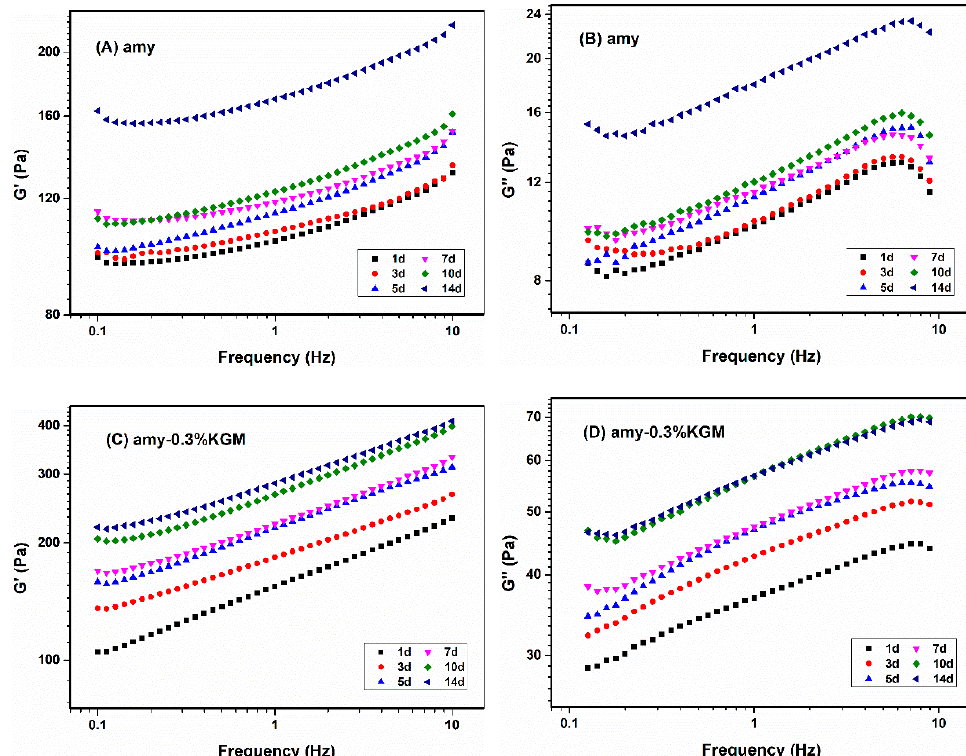
Figure 3. Frequency sweeping curves of amylose and amy-0.3%KGM at different storage times. ( A ) storage modulus of amylose; ( B ) loss modulus of amylose; ( C ) storage modulus of amylose mixed with 0.3% KGM; ( D ) loss modulus of amylose mixed with 0.3% KGM. Table 1. Composite viscosity amylose–KGM mixtures fitted by the power law equation.